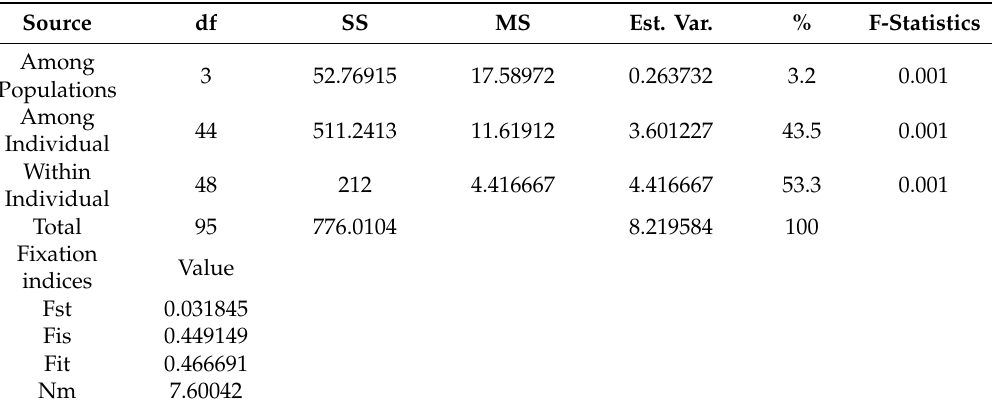
Table 6. Analysis of molecular variance among and within the 48 pigeonpea